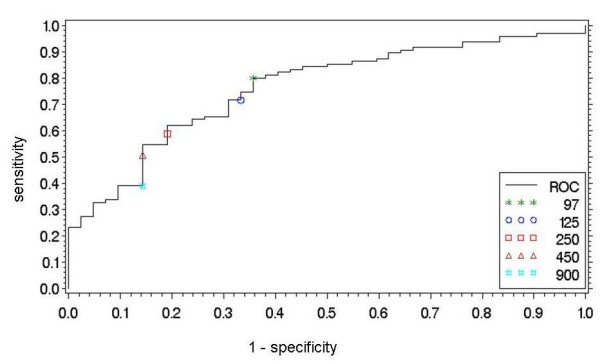
Receiver Operating Characteristic curve to evaluate the diagnostic accuracy of NT-proBNP to separate patients with diastolic and/or systolic dysfunction (n = 95) from healthy controls (n = 42). The area under the curve (AUC) = 0.763 (p < 0.0001), Youden index = 0.44. The optimal cut-off is 97 pg/ml.